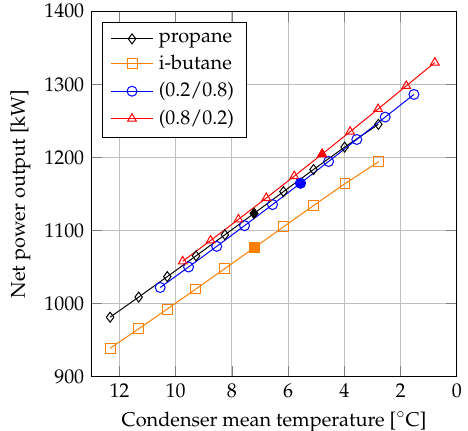
Figure 6. Net power output as a function of condenser mean temperature